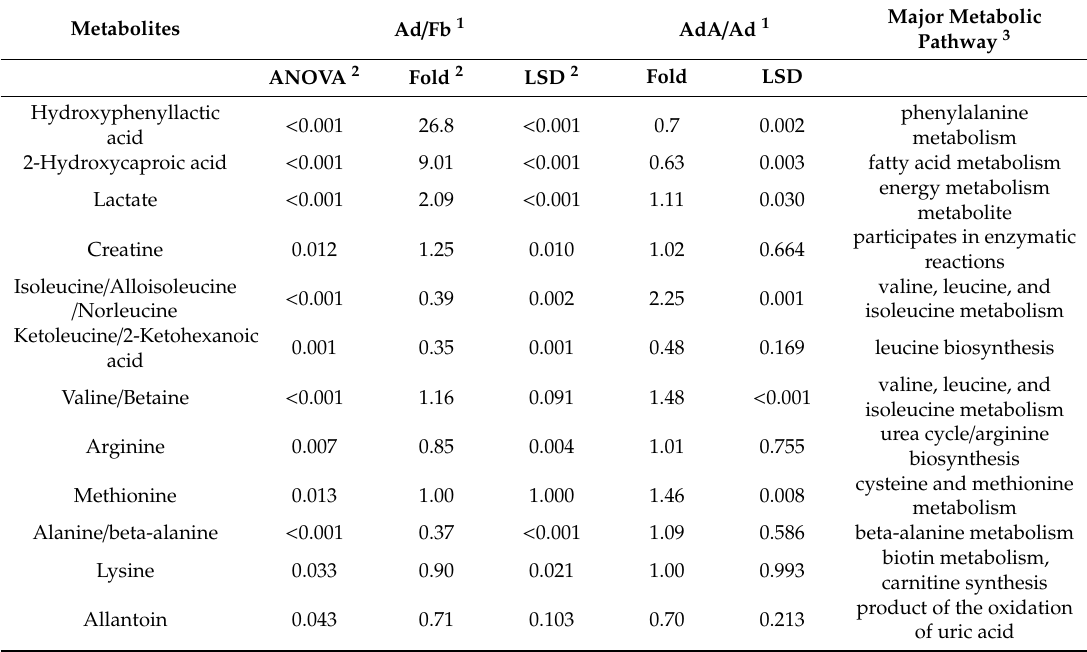
Table 1. Significant metabolites and involved pathways in 3T3-L1